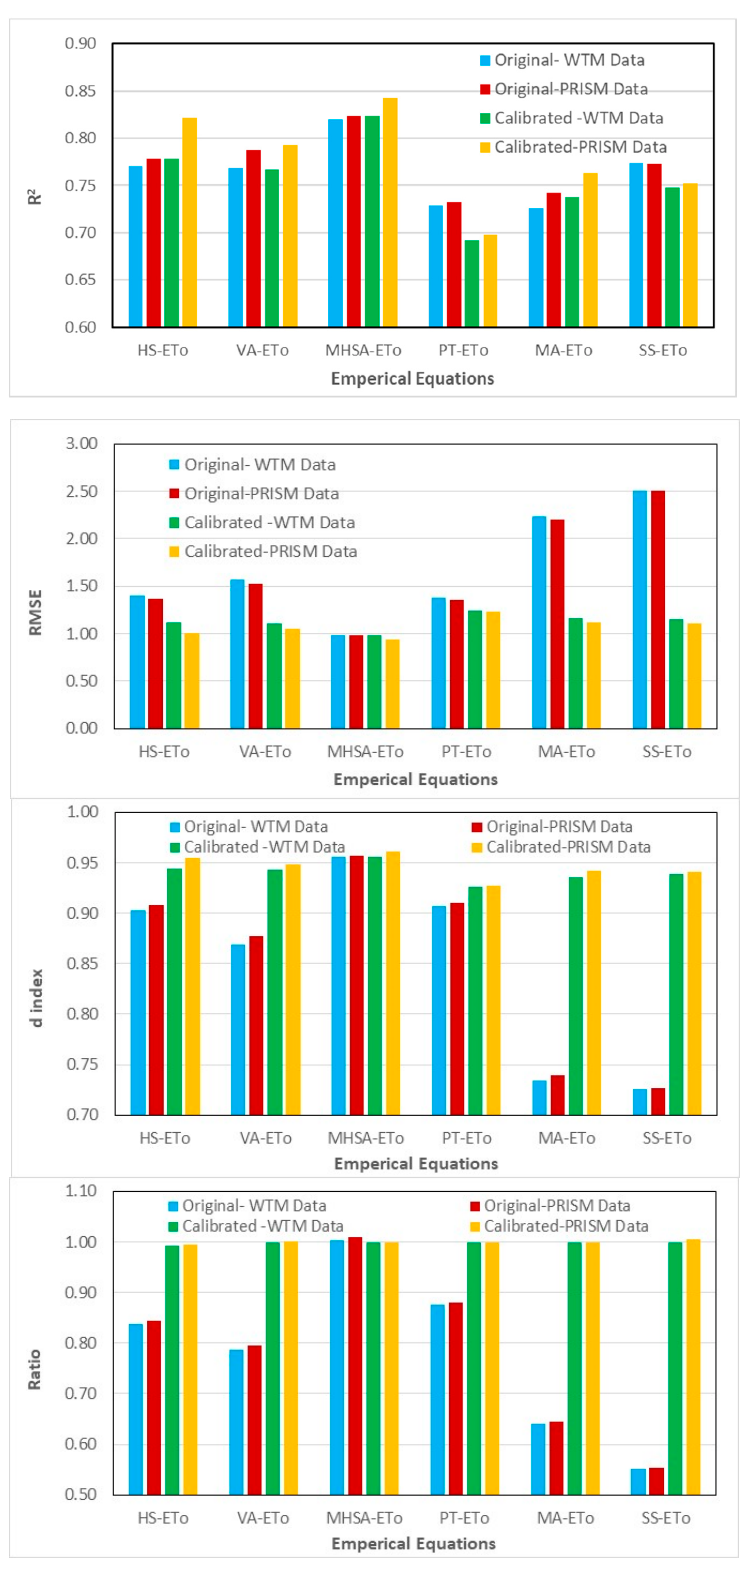
Figure 5. Performance of estimation of ET o from the selected empirical equations against the stand ‐ ard method.